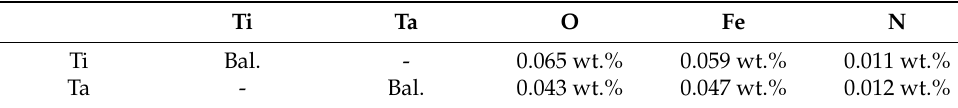
Table 1. The chemical composition content of pure Ti and Ta